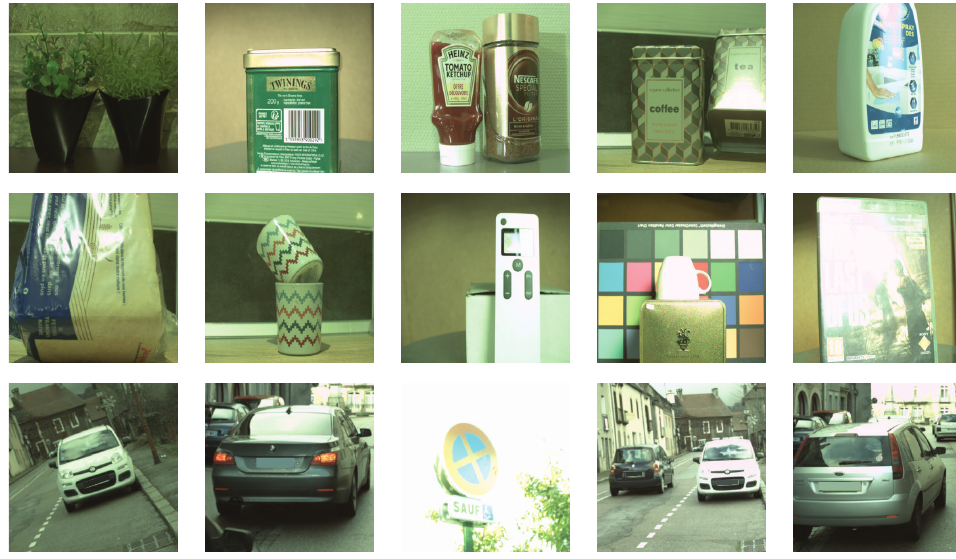
Figure 2. Real-world examples of specular reflection in